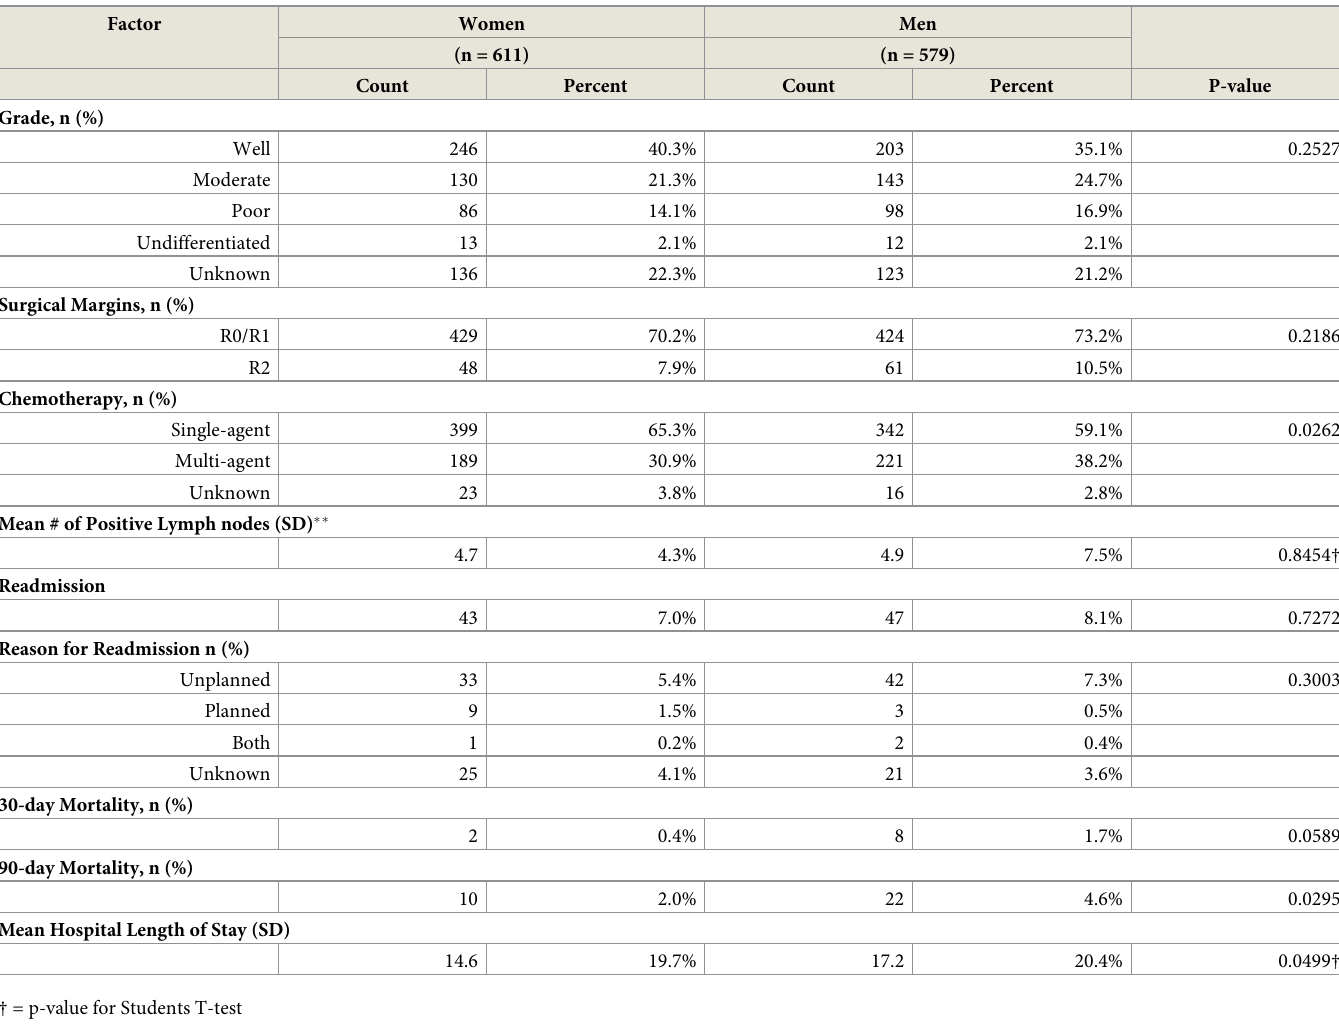
Table 2. Outcomes of patients undergoing HIPEC and CRS by gender-NCDB. Factor